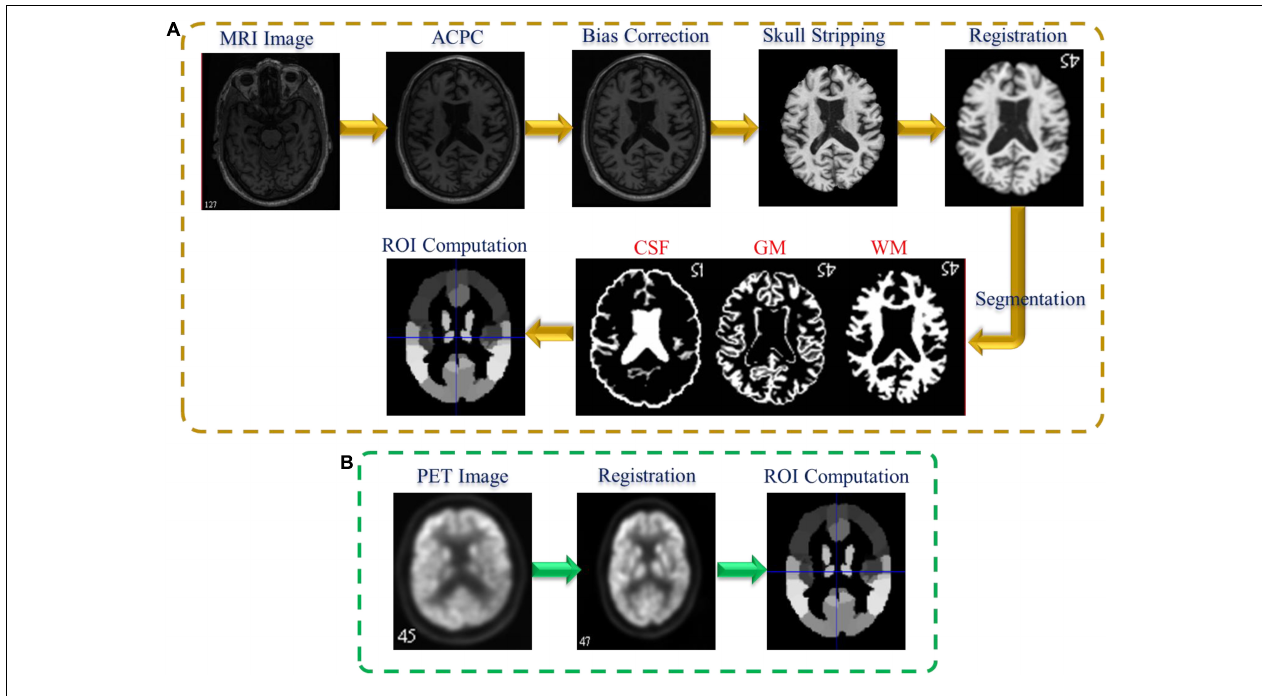
FIGURE 1 | Neuroimaging data preprocessing pipeline: (A) MRI and (B) PET.